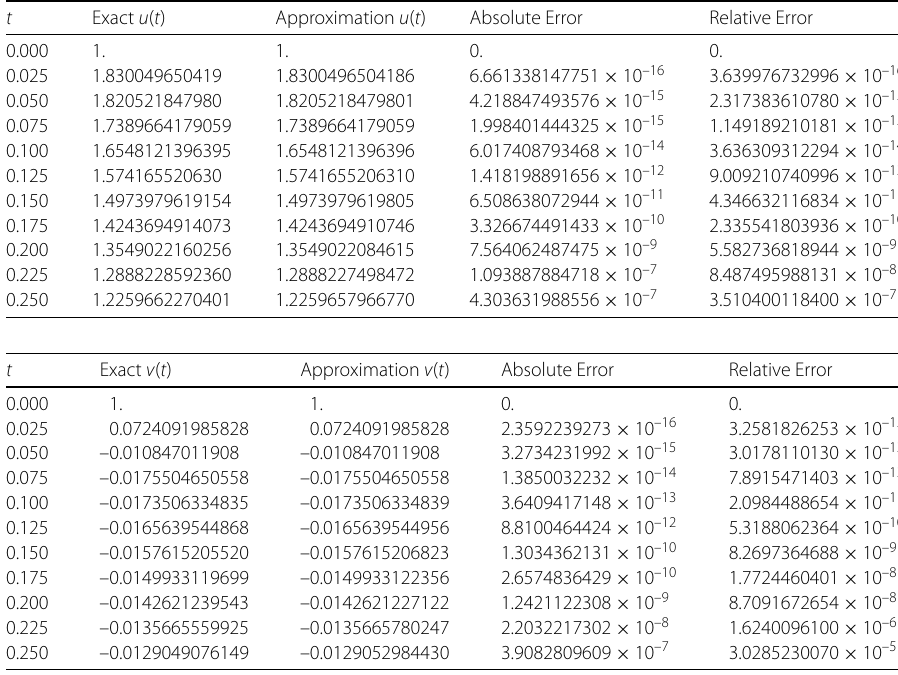
Table 1 Numerical results of the FRPS solutions at different values of t of Example 4.1